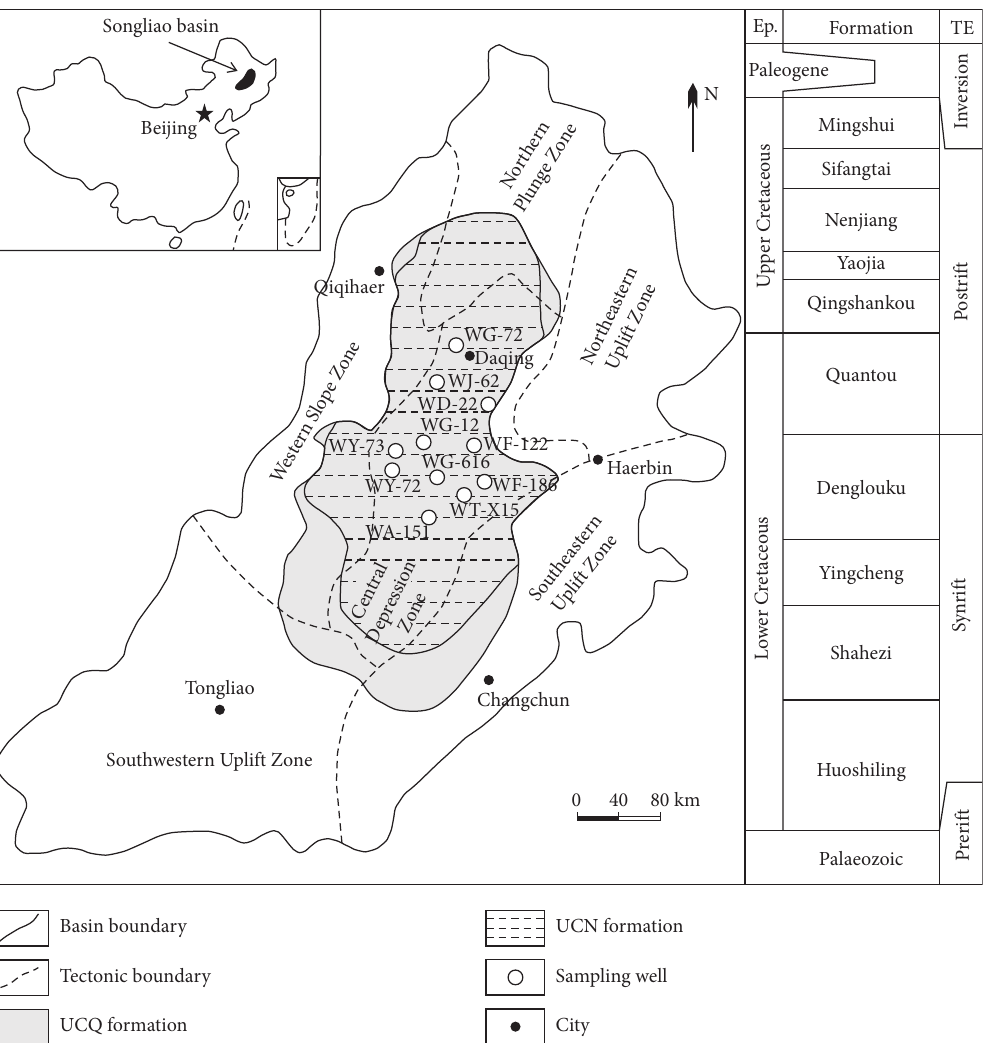
Figure 1: Sketch map of structural units and stratigraphic column of the Songliao basin with the location of sampling well (modified from Jia et al. [10] and Xu et al. [11]). Ep: epoch; TE: tectonic